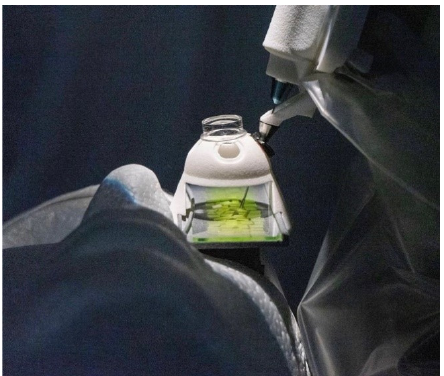
Figure 1. Practical training simulating epiretinal membrane peeling in order to familiarize the surgeon with the functionality of the Preceyes Surgical System (PSS). The phantom eye contained a gelatin layer with superficial embedded thin paper to be peeled during the training.